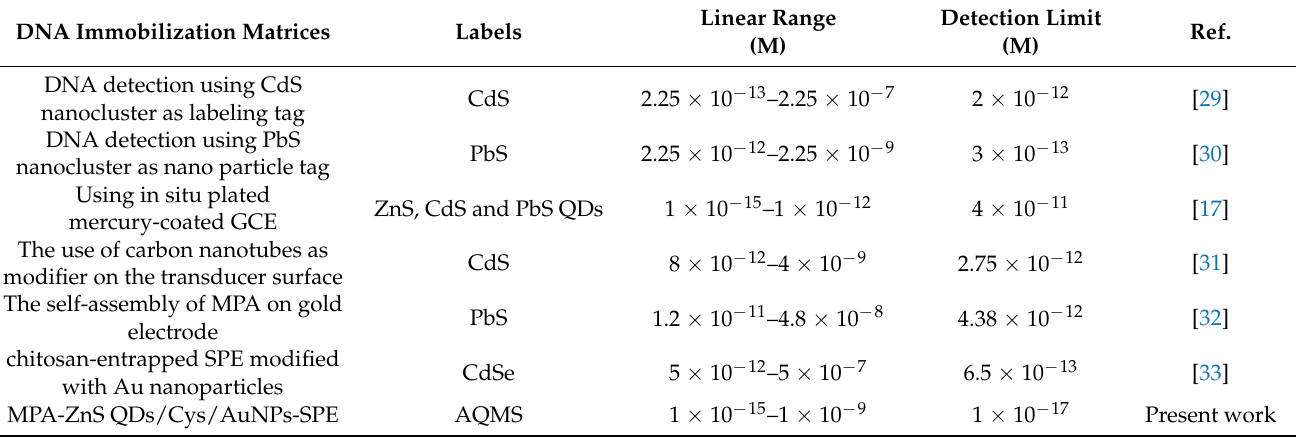
Table 2. The comparison of electrochemical DNA biosensor performance with the previously reported electrochemical DNA biosensors based on QD nanomaterials. DNA Immobilization Matrices DNA detection using CdS nanocluster as labeling tag DNA detection using PbS nanocluster as nano particle tag Using in situ